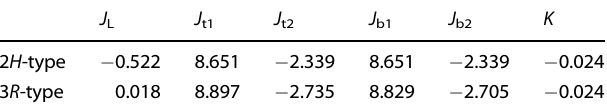
Table 1. Exchange interaction ( J , in meV) and magnetocrystalline anisotropy ( K , in meV) constant of 2 H - and 3 R -type LaBr 2 bilayer.